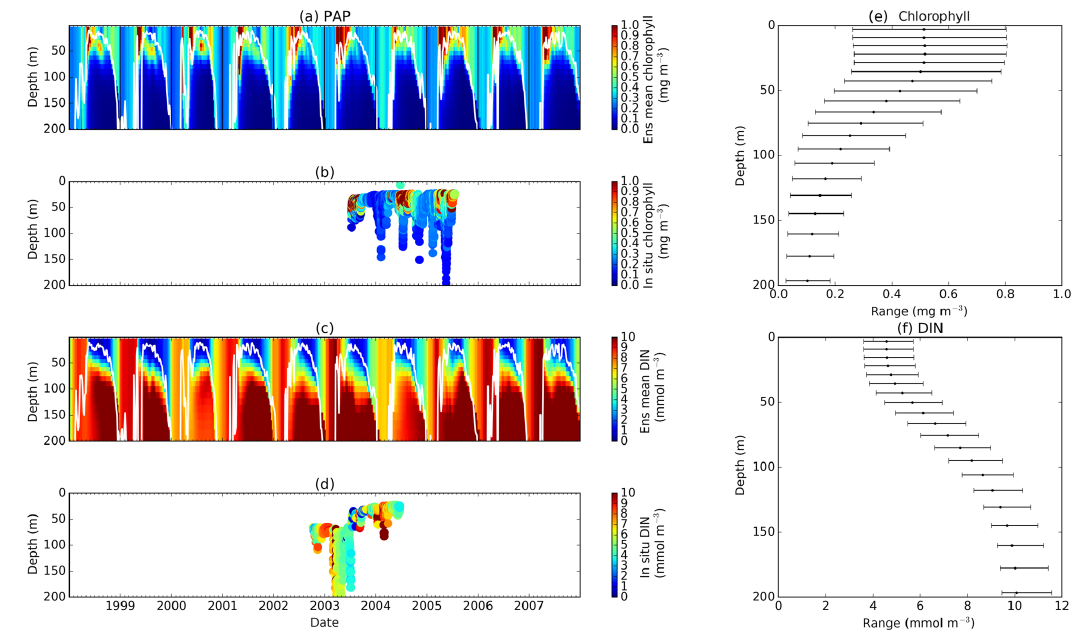
Figure 3. Chlorophyll and DIN profiles from ensemble mean ( a and c respectively), in situ observations ( b and d for chlorophyll and DIN respectively), and the 75th and 25th quartile range of concentrations at each depth ( e for chlorophyll and f for DIN) at station PAP. The ranges are obtained by averaging the concentrations from all ensemble members for 10 years at each depth. The black dots in the second column show the mean concentration of the ensemble mean over the time series (from January 1998 to December 2007). The white solid line in (a) and (c) show mixed layer